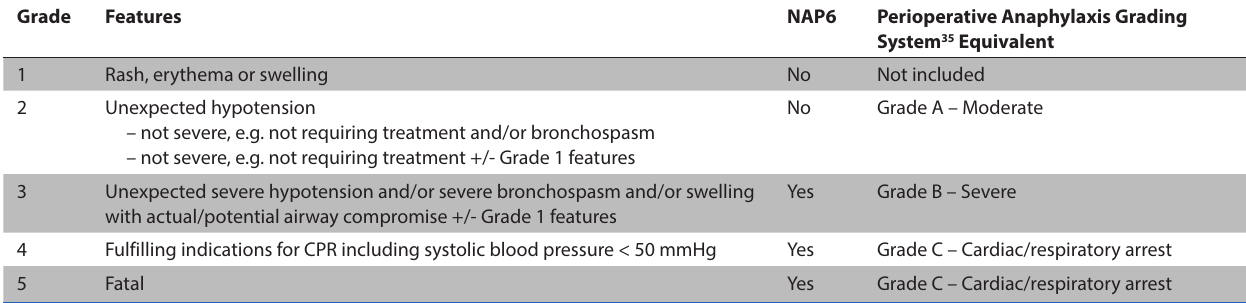
Table 6: NAP6 Perioperative Hypersensitivity/Anaphylaxis Grading System 15 Grade Features